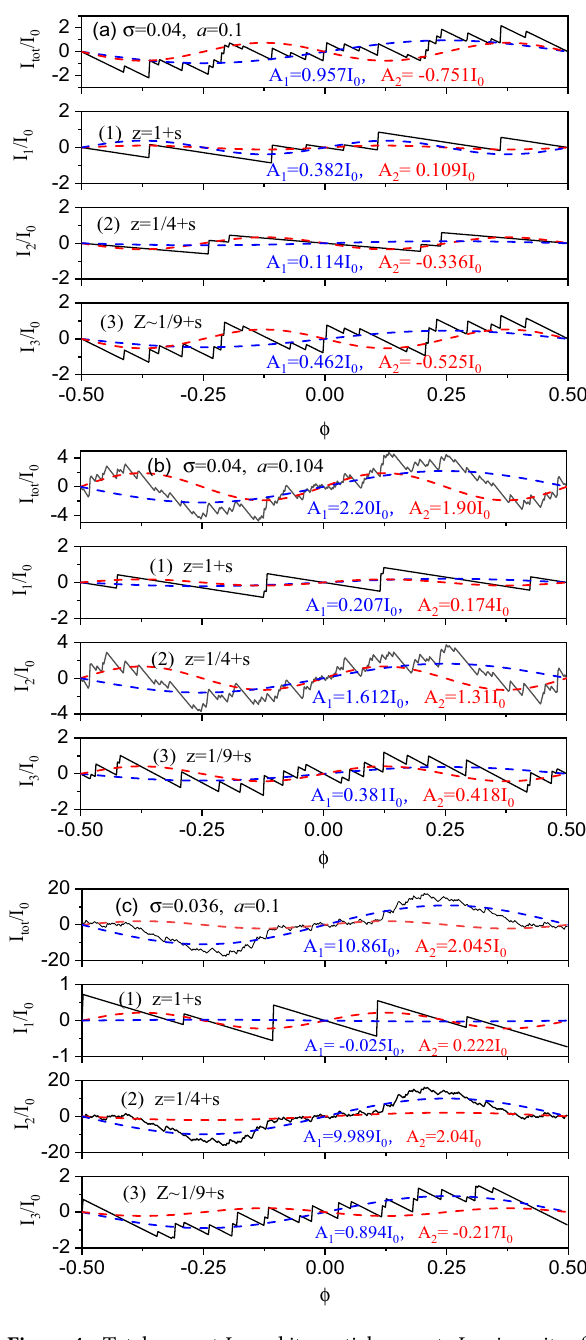
Figure 4. Total current I tot and its partial currents I 1,2,3 in units of I 0 for the various nanoring of ( a ) a = 0.1 and σ = 0.04, ( b ) a = 0.104 and σ = 0.04, and ( c ) a = 0.1 and σ = 0.036. Below I tot -curves are three partial currents I 1,2,3 for (1) z = 1 + s , (2) z = 1/4 + s , and (3) z = 1/9 + s . For the signs of PC, the first two Fourier harmonics A 1 and A 2 are present